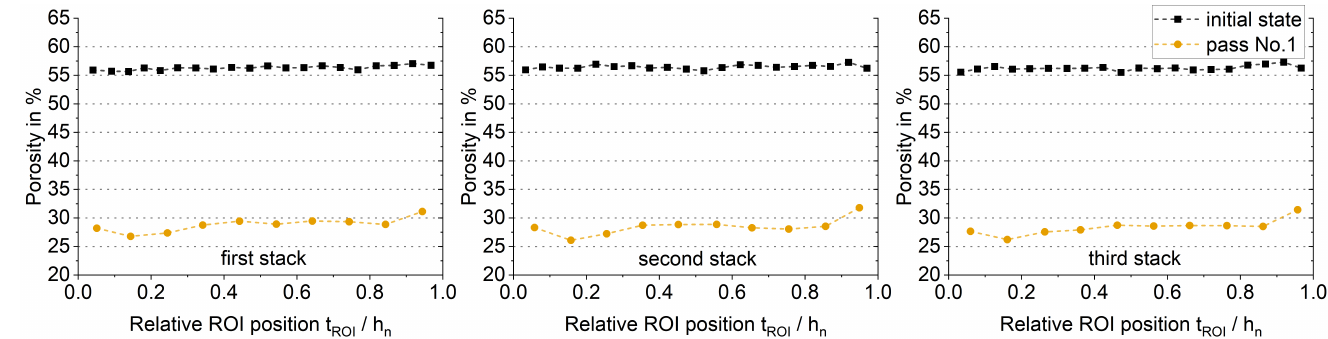
Figure A7. Series II: 20-0.50-1 ( l d / h m ≈ 2.1): Porosity change over relative sample depth (0=upper surface; 0.5= mid-section of sample; 1 =lower surface) due to rolling for first, second and third stack.